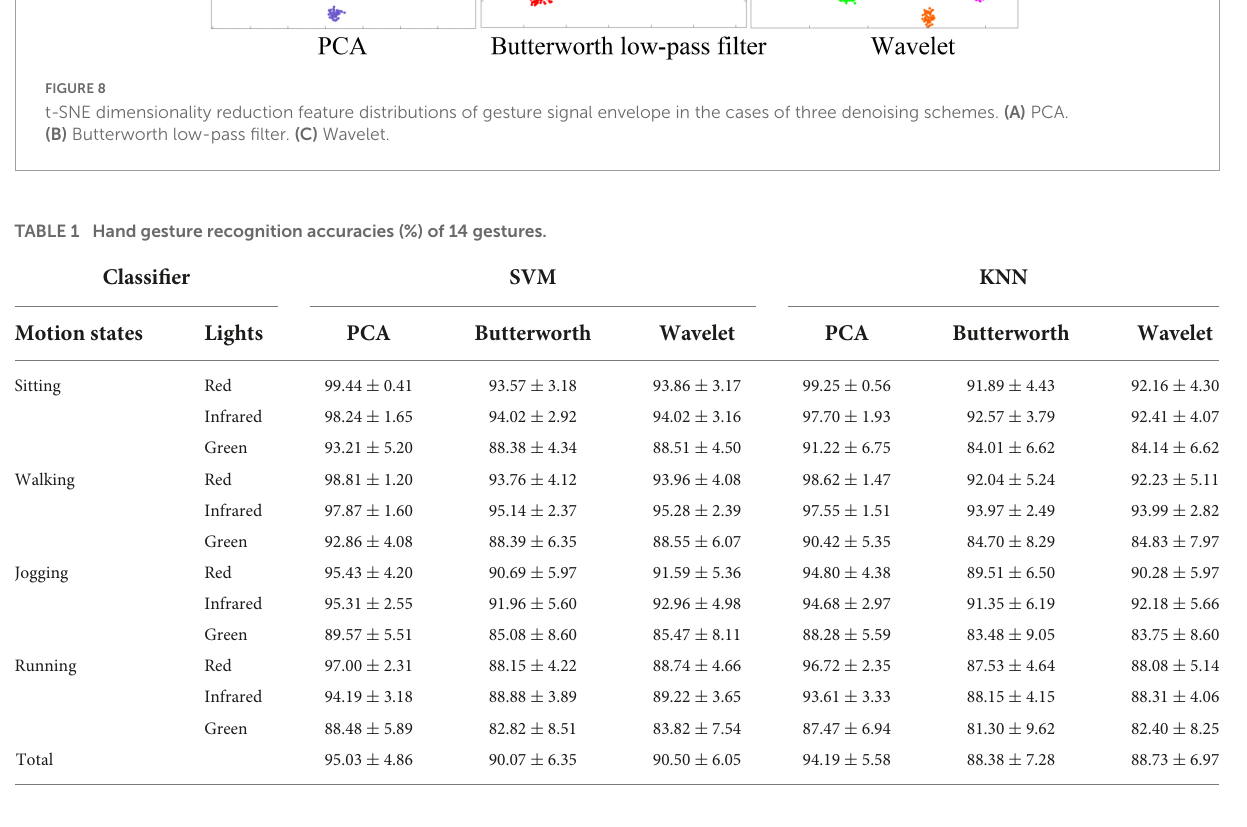
TABLE 2 The results of non-parametric tests for gesture recognition. Factors Sig.